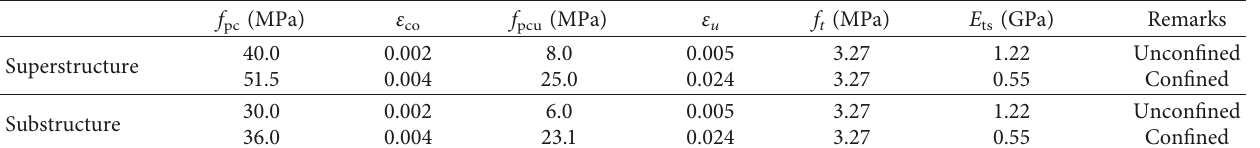
Table 1: Concrete material properties.